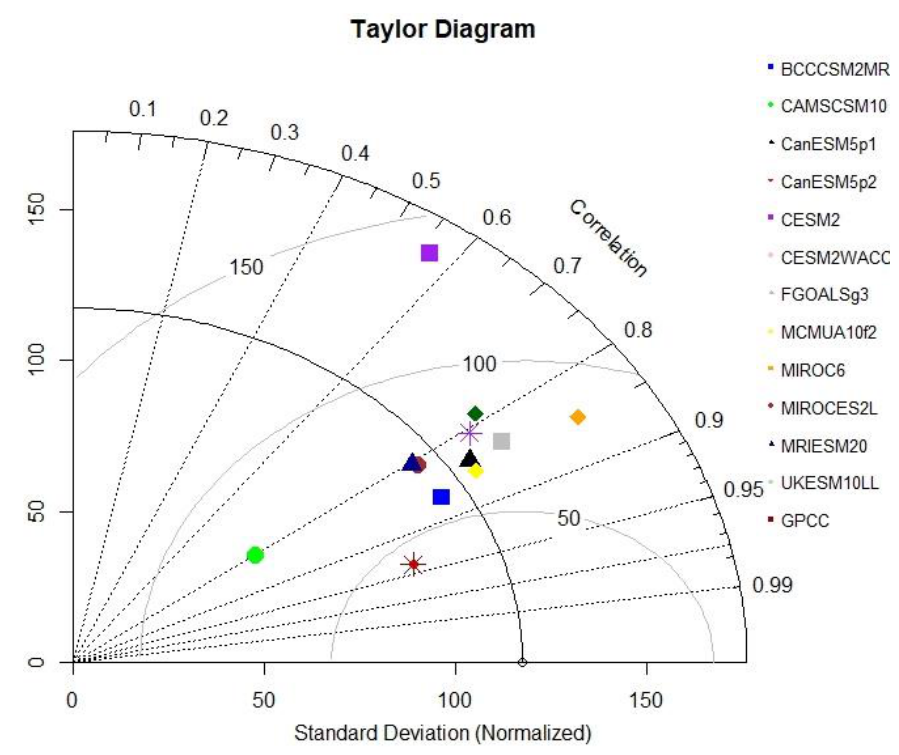
Bold values are selected model highest performance values for statistical parameters.